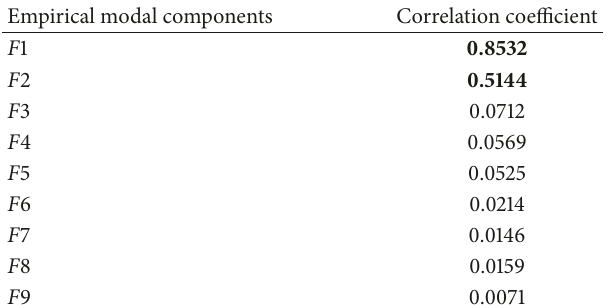
Table 4: Correlation coefficient between empirical modal compo- nents and preprocessed noise signal.